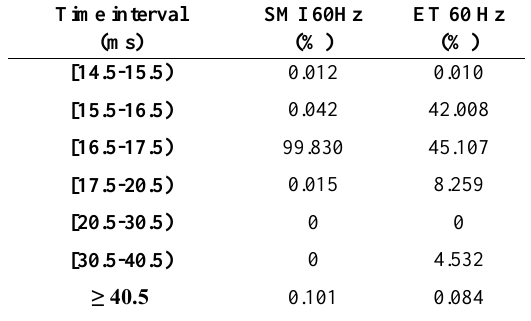
Table 4: Recorded time intervals between samples at 60